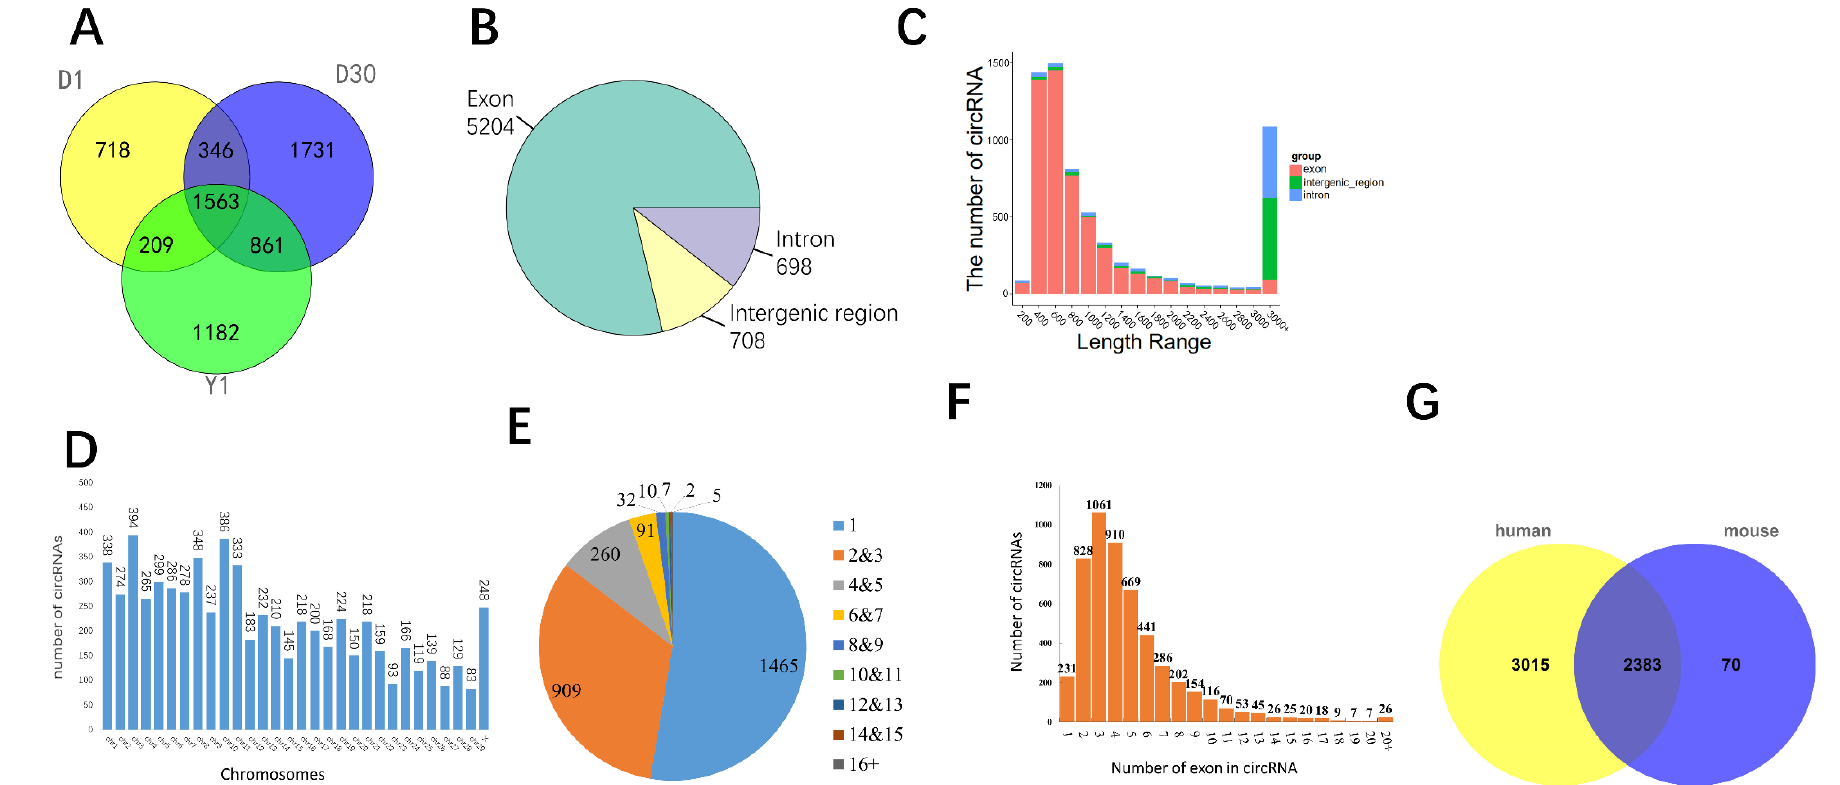
Figure 2. Identification and characteristics of Circular RNA in goat perirenal fat. ( A ) The number of circRNAs in three stages. ( B ) Distribution of circRNAs in the genome. The green region represents exon region, the yellow represents intergenic region, and the purple represents intron region. ( C ) circRNA length distribution of all circRNAs from twelve tissues. ( D ) The number of circRNAs in each goat chromosomes. ( E ) circRNA isoforms produced from one gene. ( F ) Exon number consisted in one circRNA. ( G ) circRNA conservation analysis among goat, human, and mouse. The yellow circle showed the population of conserved human circRNAs, whereas the blue circle showed the conserved mouse circRNAs. The junction part demonstrated the conserved circRNA number among goat, human, and mouse.